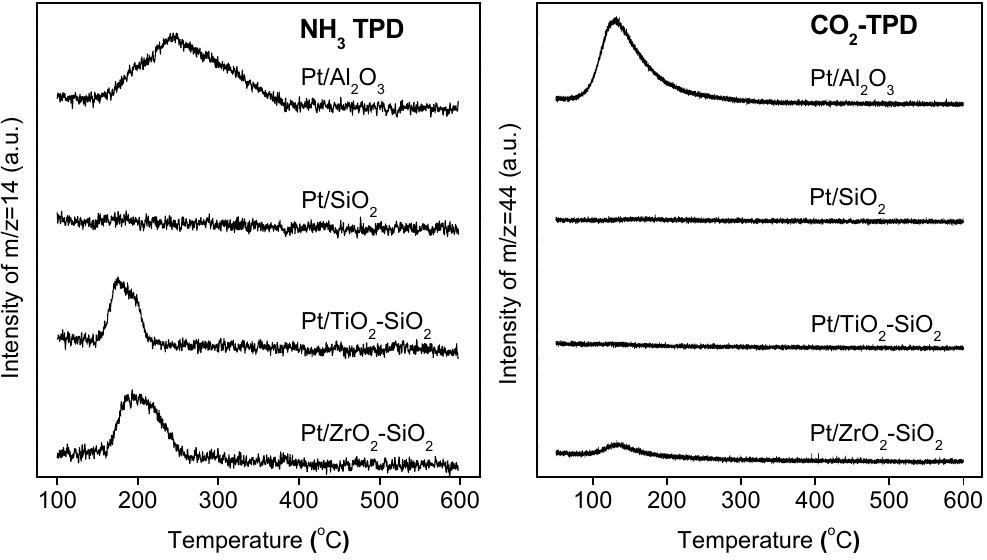
and CO 3 -SiO 2 2